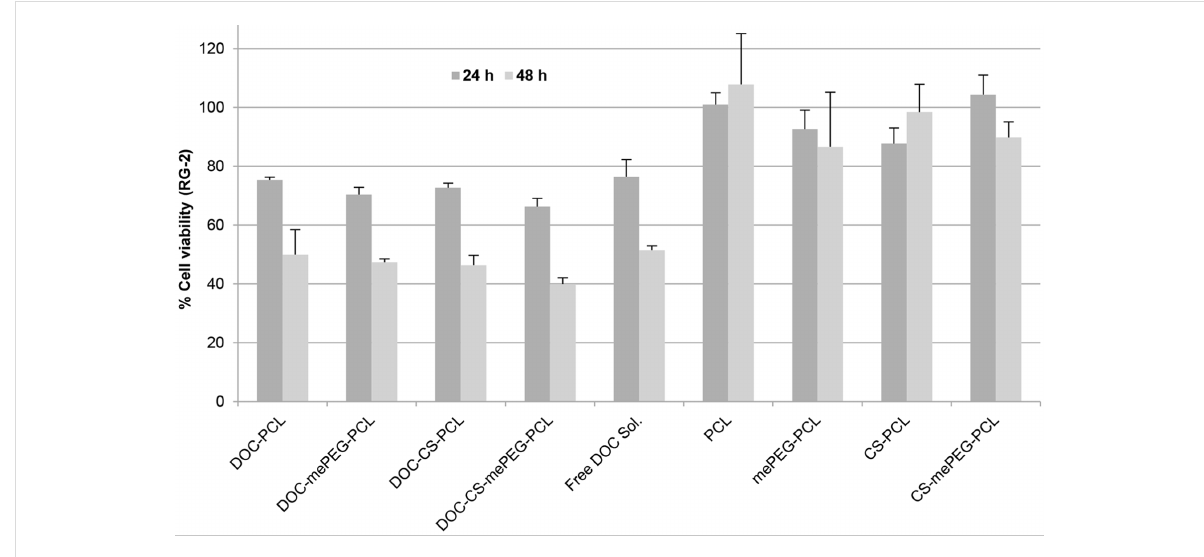
Figure 7: RG2 cell viability with blank and DOC-loaded nanoparticles for 24 and 48 h ( n = 3, ± SD).